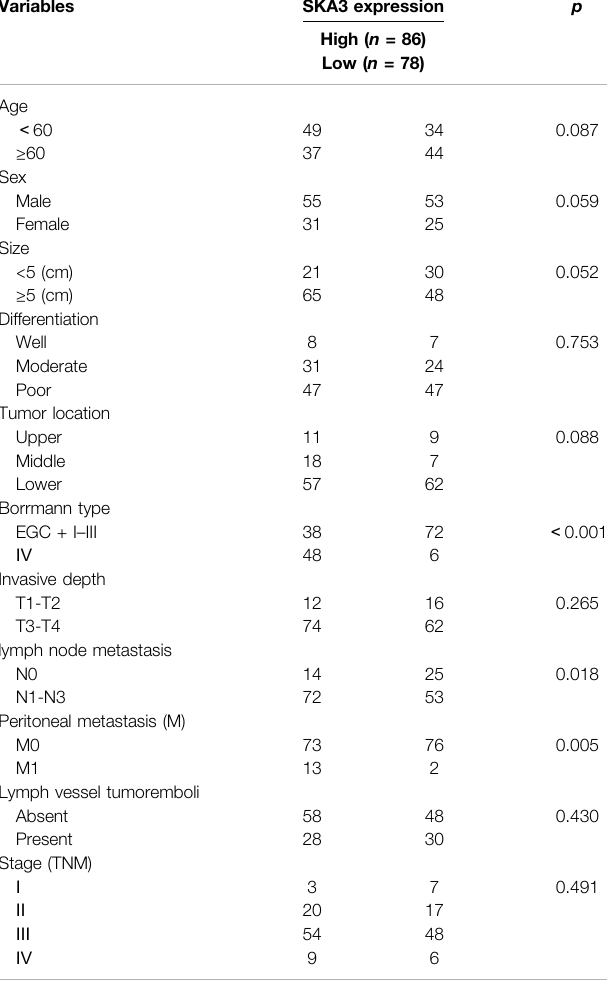
TABLE 1 | Relationship between the SKA3 expression and clinical parameter.